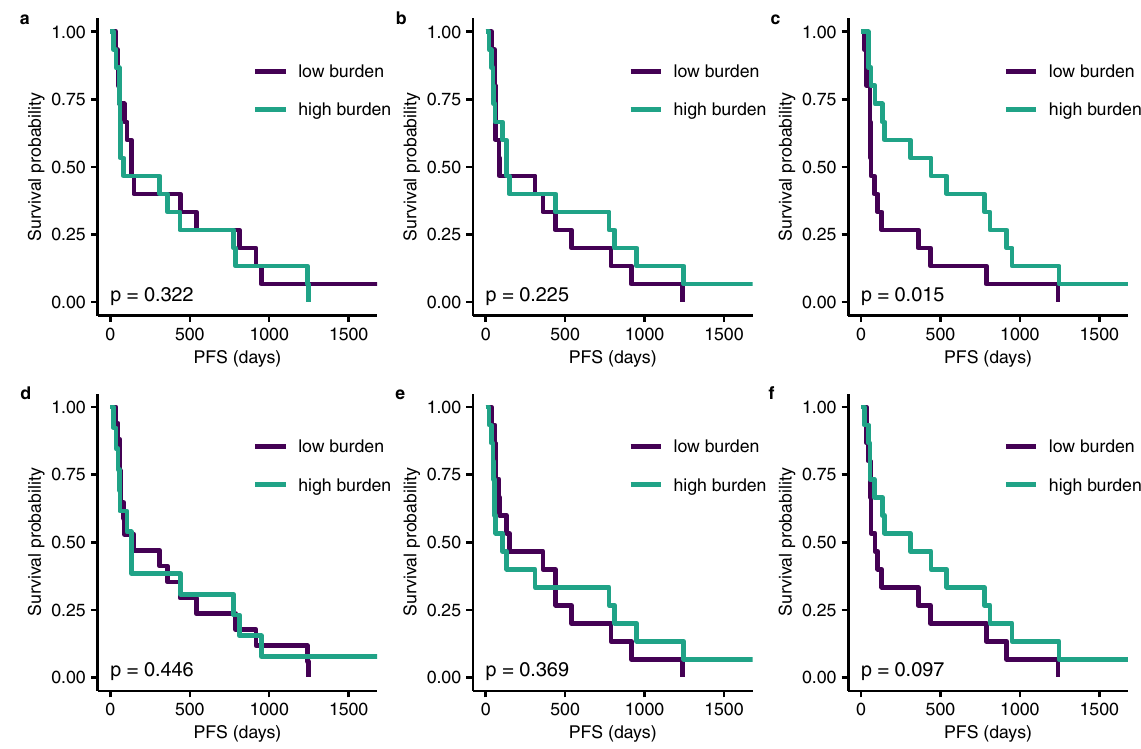
Fig. 5 Kaplan – Meier curves for progression-free survival (PFS) on the pre-treatment cfDNA sequencing data of 30 advanced NSCLC patients. a – c Kaplan – Meier curves based on truncal-bTMB calculated using MuTect, Strelka2, and cfSNV. The high-burden and low-burden groups in each plot are de fi ned by the median value of the measure: MuTect ( a , hazard ratio (HR) = 0.839, 95% CI [0.403, 1.747], Z statistic = − 0.48), Strelka2 ( b , HR = 0.745, 95% CI [0.352, 1.581], Z statistic = − 0.76), or cfSNV ( c , HR = 0.438, 95% CI [0.205, 0.938], Z statistic = − 2.07). d – f , Kaplan – Meier curves based on bTMB calculated using MuTect, Strelka2, and cfSNV. The high-burden and low-burden groups in each plot are de fi ned by the median value of the measure: MuTect ( d , HR = 0.948, 95% CI [0.451, 1.990], Z statistic = − 0.14), Strelka2 ( e , HR = 0.883, 95% CI [0.415, 1.880], Z statistic = − 0.33), or cfSNV ( f , HR = 0.611, 95% CI [0.288, 1.295], Z statistic = − 1.29). All p -values were calculated from one-sided log-rank test. There is no multiple testing